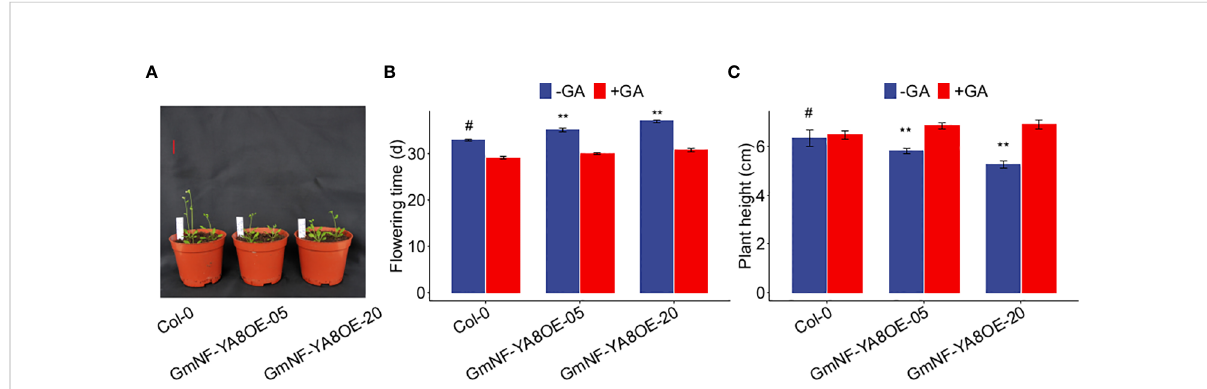
FIGURE 6 Ectopic expression GmNF-YA8 delays fl owering in Arabidopsis (A) Photographs were taken when the fi rst fl ower had opened in Col-0, but not in GmNF-YA8OE-05 and GmNF-YA8OE-20 plants. Scale bar, 2 cm. (B) The fl owering time was measured when the fi rst fl ower was opened in Col-0, GmNF-YA8OE-05 and GmNF-YA8OE-20, respectively. (C) Plant height was measured when the fi rst fl ower was opened. Results are means ± SE from each 12 Col-0, GmNF-YA8OE-05 and GmNF-YA8OE-20 plants, respectively. Difference between Col-0 and the transgenic lines GmNF-YA8OE-05 and GmNF-YA8OE-20 were compared using Student ’ s t -test (** P < 0.01; #, the